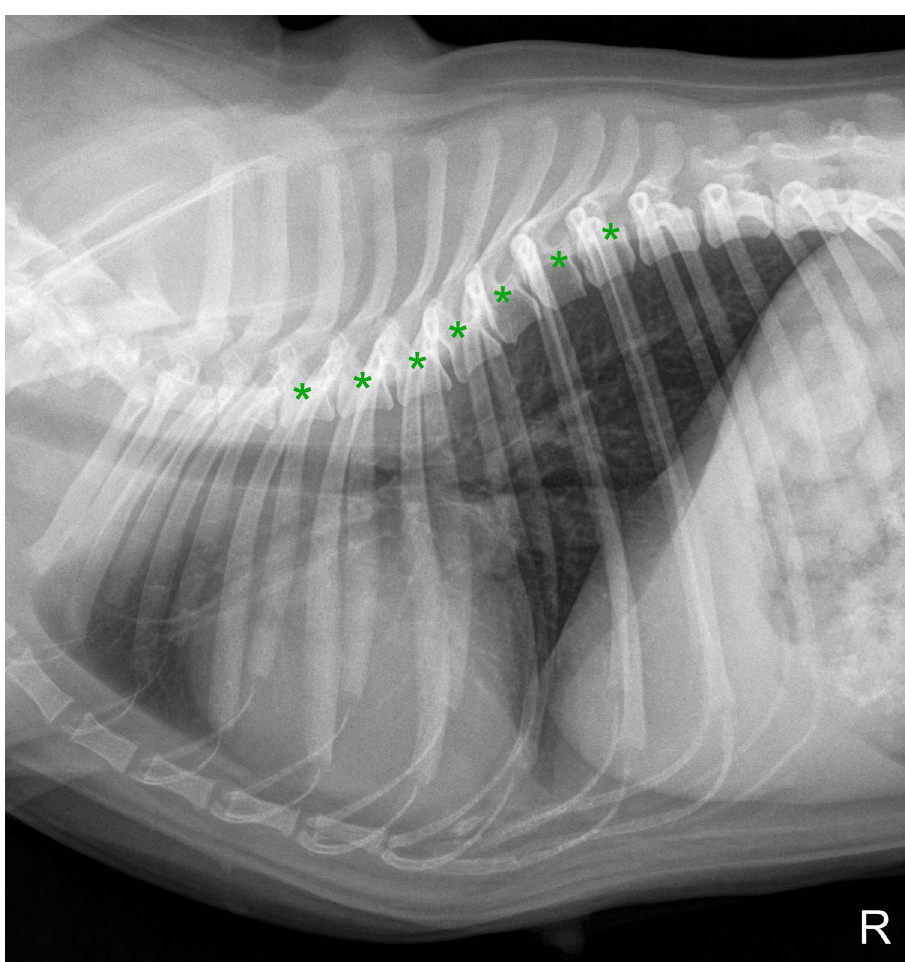
Fig 5. Right laterolateral thoracic radiograph of a five-year-old female pug showing irregularly shaped and trapezoid thoracic vertebrae throughout the thoracic spine (marked with asterisks), leading to exclusion from radiographic